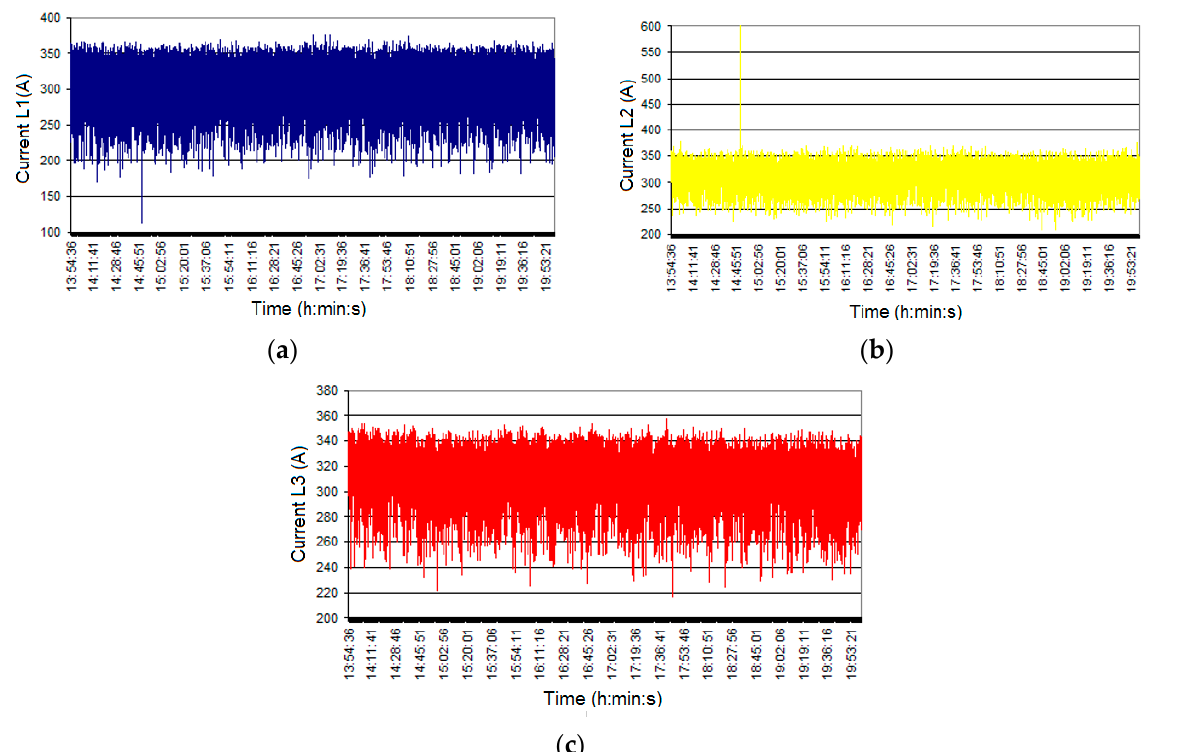
Figure 19. The RMS line voltage values in the primary of a step ‐ up transformer for an ESP with three sections: ( a ) voltage L1 ‐ L2; ( b ) voltage L2 ‐ L3; ( c ) voltage L3 ‐ L1.